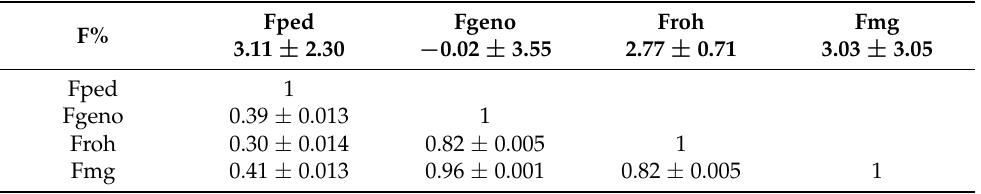
Table 1. Average inbreeding coefficient (F% ± SD) and correlations ( ± SE) among the inbreeding calculation methods (below diagonal; p <